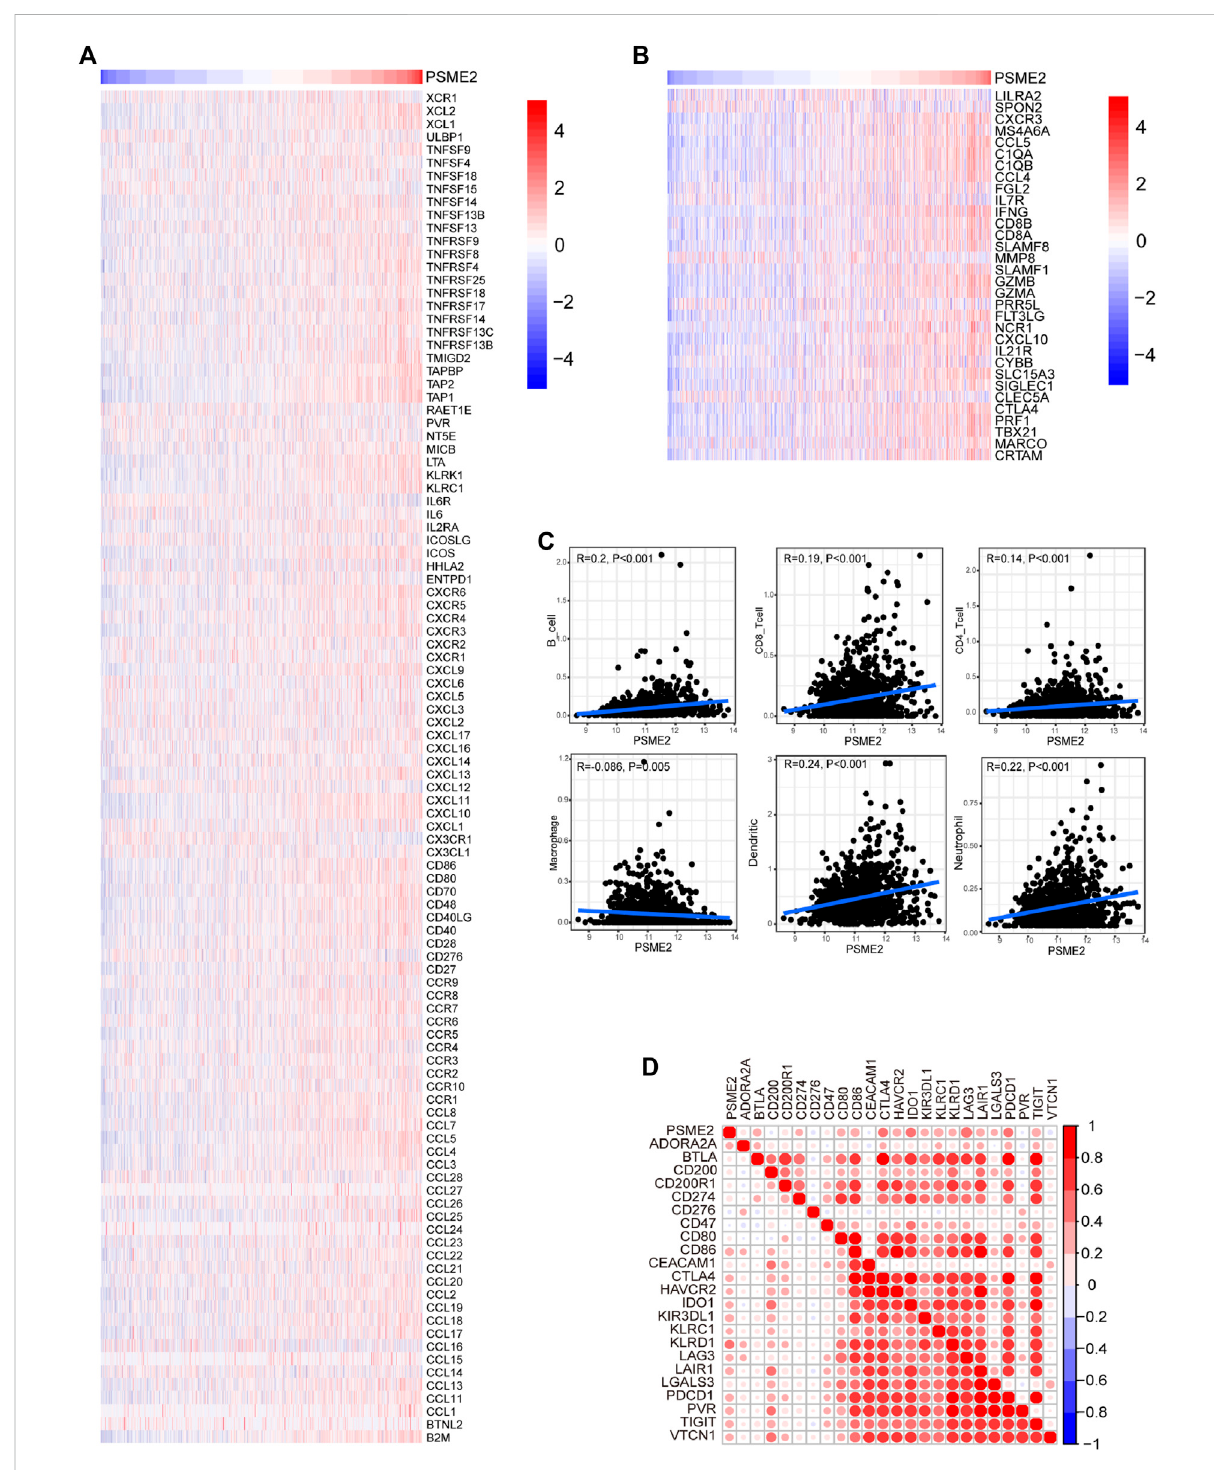
Associations between PSME2 and TIME features in the TCGA dataset (A) Expression levels of immunomodulators (chemokines, immunostimulators, MHC, and receptors) in the high- and low-PSME2 groups in BrCa. Red: high expression, blue: low expression (B) Expression levels of the gene markers of the common TIICs in the high- and low-PSME2 groups. Red: high expression, blue: low expression (C) Correlation between PSME2 and levels of TIICs calculated using the TIMER algorithms (D) Correlations between PSME2 and common inhibitory immune checkpoints. The color and the values indicate the Pearson correlation coef fi cient. Data of Figure 4 was obtained from the TCGA